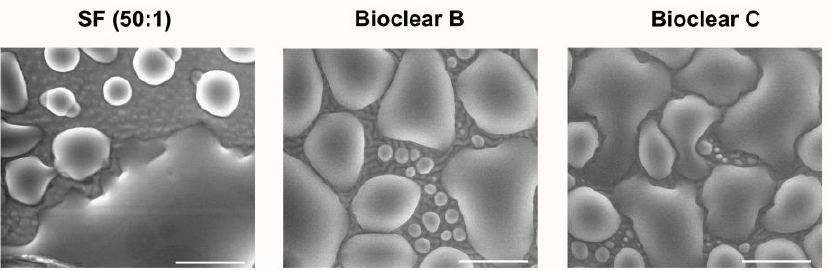
Figure A5. ESEM images of condensed and coalesced water droplets on PF-PDMS surfaces during the drop growth phase. The Droplets adhere to the surfaces and spread cross the wrinkles while exhibiting low contact angles. (Scale bar: 100 µm).